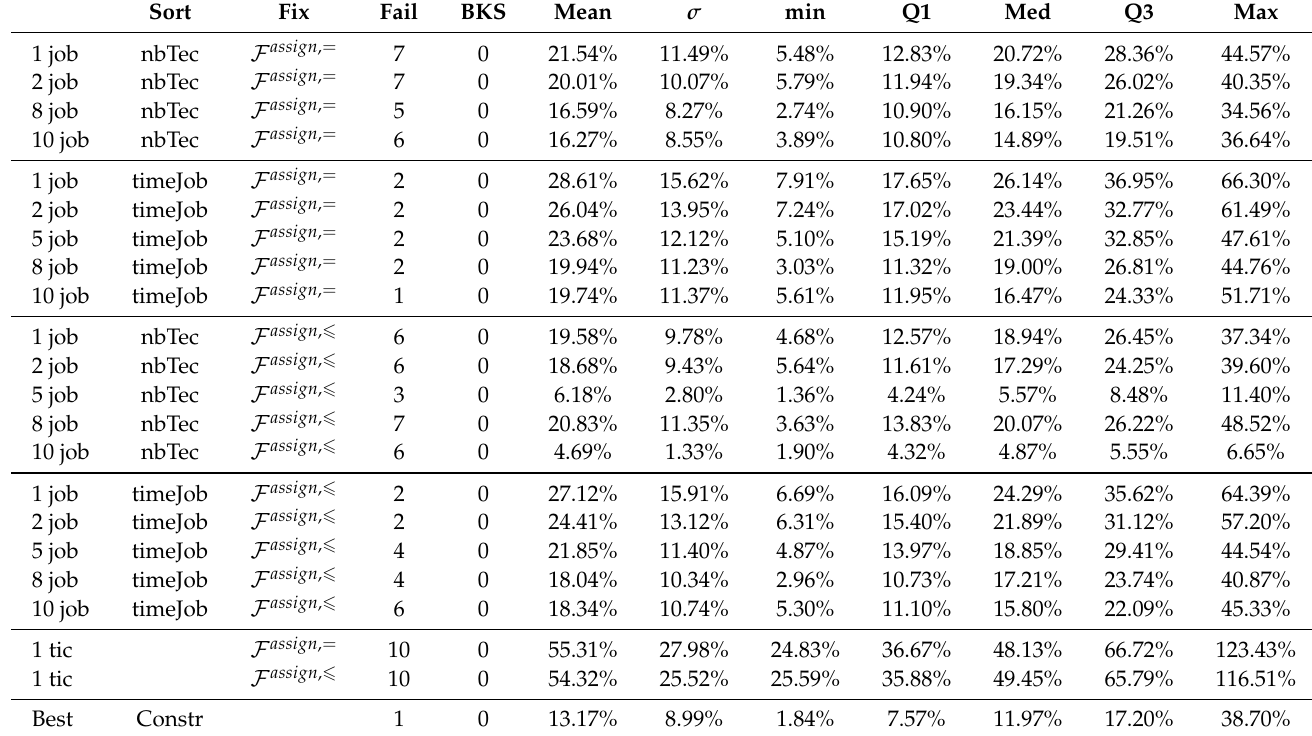
Table 4. Comparison of the statistical indicators presented in Section 6.1.2 using several constructive matheuristics for all the instances. n job denotes Algorithm 2 grouping in subsets of n jobs, and 1tic denotes Algorithm 1. For job insertion, the initial sorting of jobs is based on the number of technicians that can realize the jobs (nbTec) or with the cumulated time